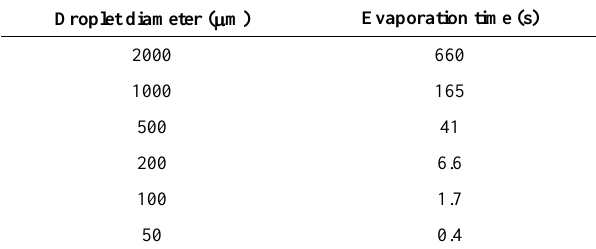
Table 1. Evaporation Time of Water Droplets